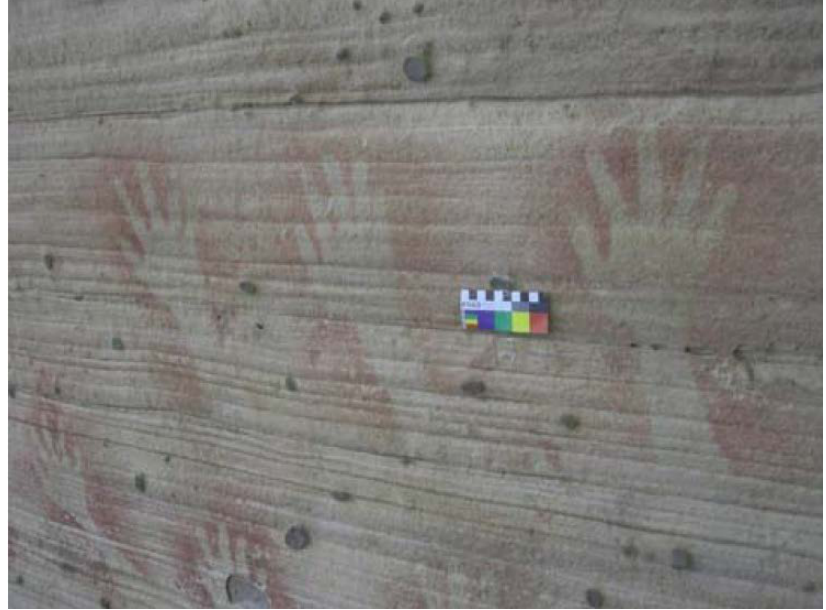
Figure 27. Hand stencils from Wadi Qara, Jazan area.